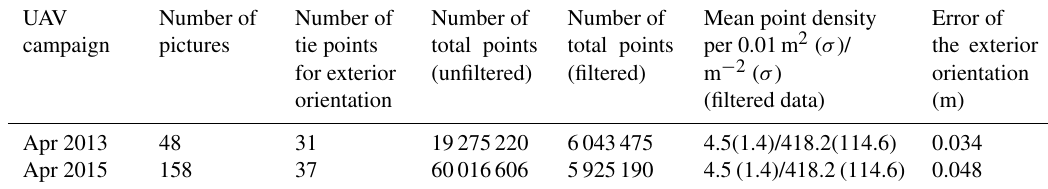
Error of the exterior orientation